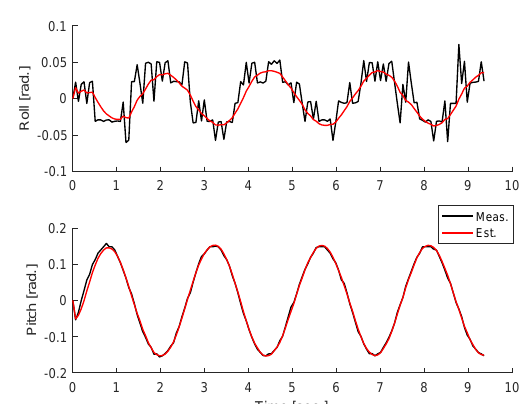
Figure 9: The measured and estimated values of the pitch case.